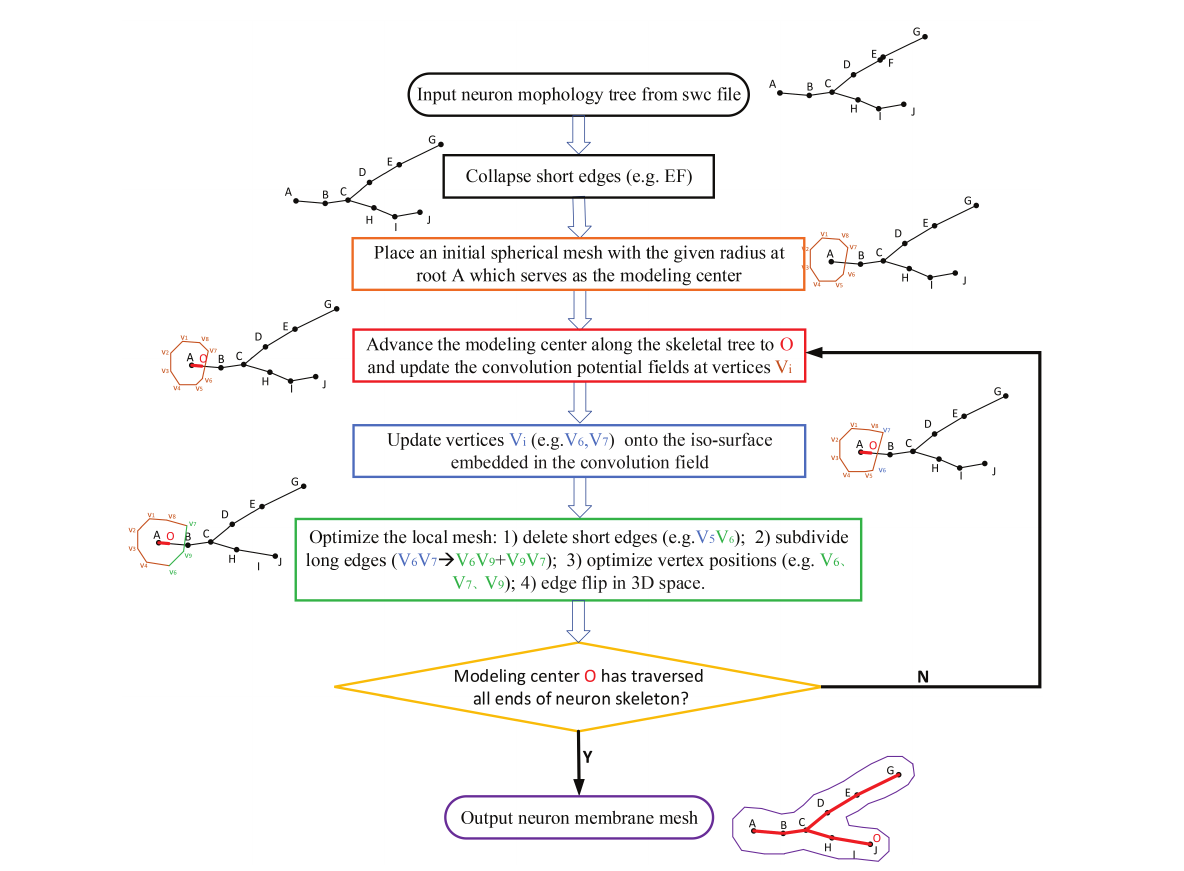
FIGURE4 The workflow for the progressive meshing of neuronal morphology. The procedure starts from an initial soma mesh at the root of the neuron tree, then searches the vertices affected by the skeleton-based implicit surfaces, and finally projects these vertices onto the implicitly defined convolution surfaces for further remeshing if the relevant edges are longer than the predefined threshold.